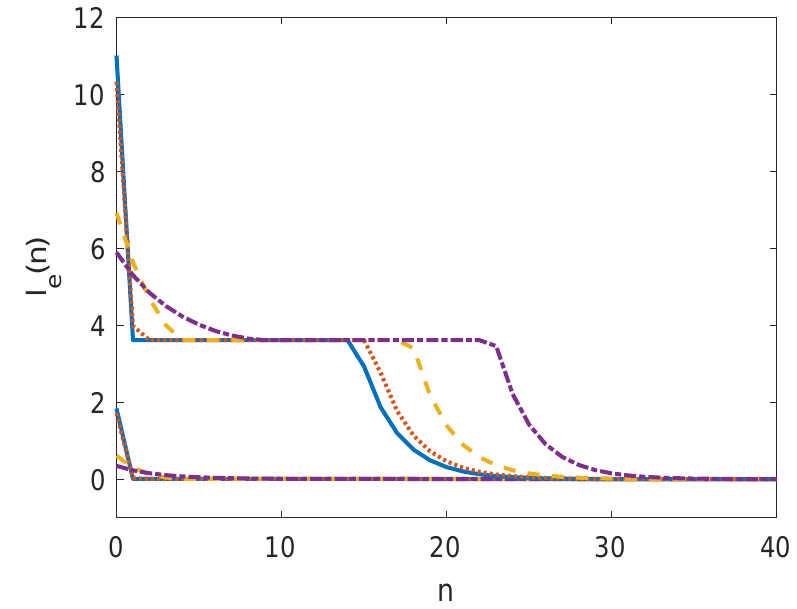
Figure 2. Closed-loop economic performance of EMPC of Equation (10) with c 1 = 10 4 and c 2 = 10 2 (solid), c 2 = 10 3 (dotted), c 2 = 10 4 (dashed), c 2 = 10 5 (dash dotted), respectively. The upper and lower part correspond to initial state x ( 0 ) = 5 and x ( 0 ) = − 5,